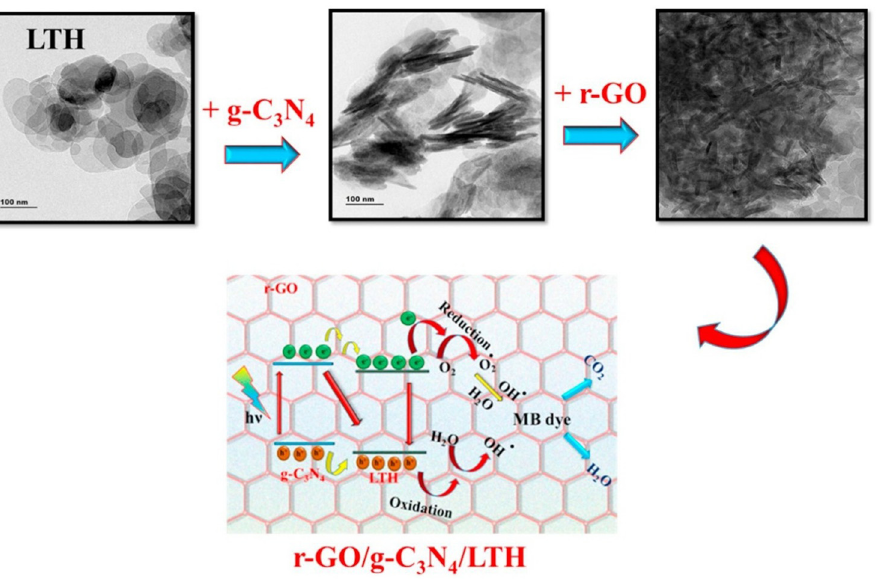
Figure 11: Schematic image of possible photocatalytic reaction mechanism of MB dye degradation. Reproduced with permission from ref. [ 95 ] ; copyright ( 2020 ) , Elsevier.